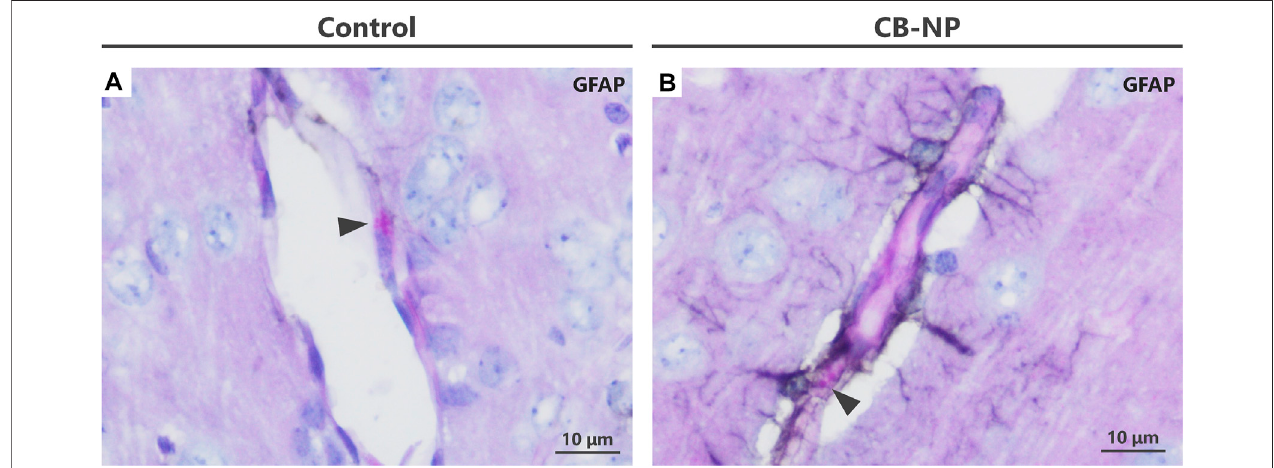
FIGURE 5 | PAS-immunohistochemistry using diaminobenzidine (DAB) with cobalt. When the DAB substrate was mixed with cobalt, the brown turned black or darkbrown. (A,B) LightmicrographsofPVMsandastrocytesstainedwithPAS-immunohistochemicaldoublestainingusingaDAB-cobaltsubstrate.Theastrocyteend- feetwerestainedblack.ThisstainingwithDAB-cobaltissuitablewhenthestainingofastrocytesneedstobeemphasized.ArrowheadsindicatePAS-positivegranulesin PVMs.